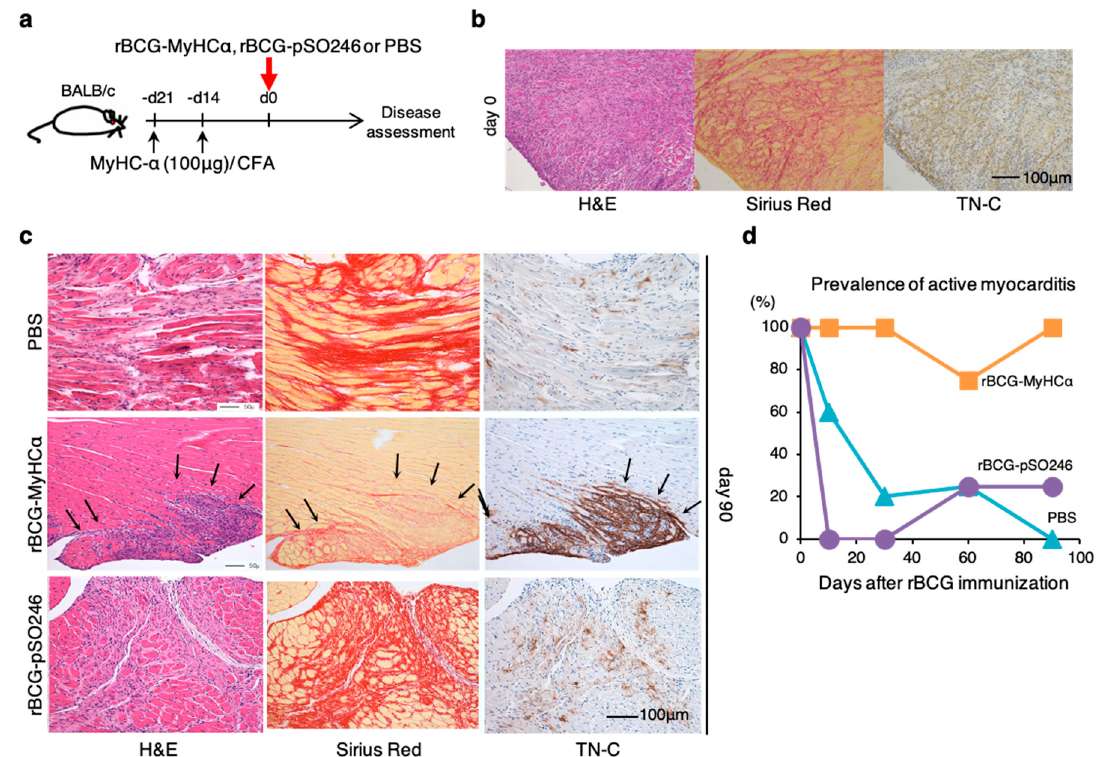
Figure 5. A model of prolonged chronic myocarditis following acute myocarditis. ( a ) Mice were immunized twice with 100 µ g of MyHC α peptide/CFA on days 14 and 21 before rBCG immunization to induce EAM. rBCG-MyHC α , rBCG- pSO246, or PBS were injected subcutaneously on day 0. ( b ) Representative histology of the heart sections on day 0 (21 days after first immunization with MyHC α ). ( c ) Representative histology of the heart sections at 90 days after rBCG immunization. ( d ) Prevalence of active myocarditis, n = 5–6 at each time point for each group.